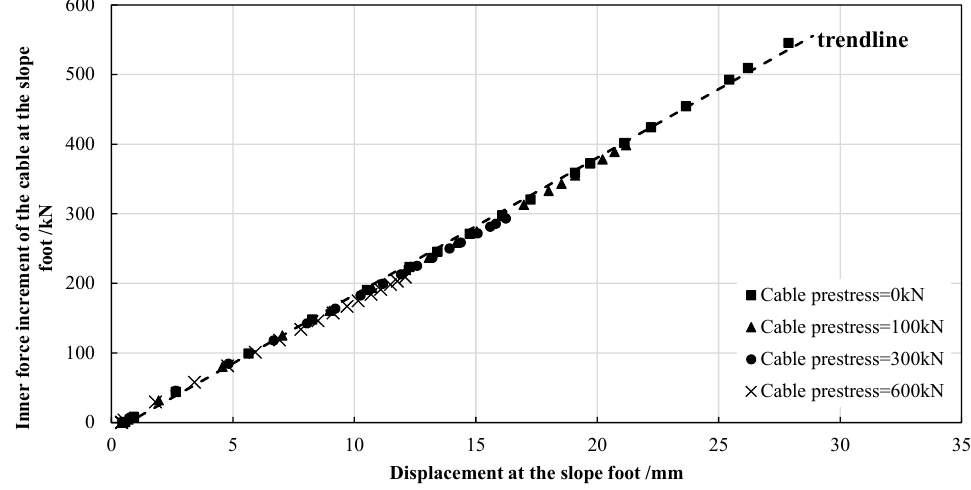
Figure 13. Relationship between the displacement of the slope foot and the increment thereof in cables at the slope foot.